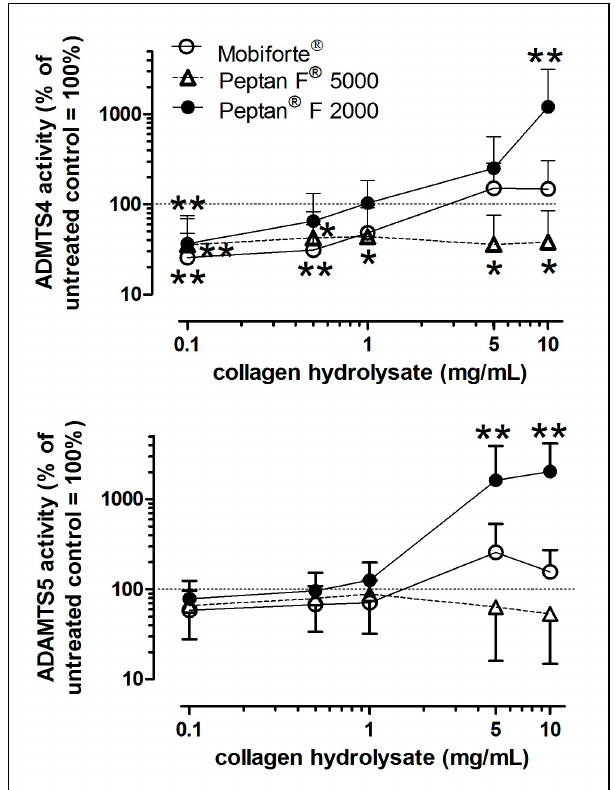
Figure 5. Concentration-dependent effects of CHs on the activities of aggrecanases. The activities of rhADAMTS4 ( A ) and rhADAMTS5 ( B ) in the presence or absence of 0.1, 0.5, 1, 2 and 10 mg/mL of Mobiforte ® , Peptan ® F 5000 or Peptan ® F 2000 were determined using the rhAggrecan-IGD as a substrate. The activities of both aggrecanases are expressed as the percentage of untreated controls (=100%). Data are shown as the mean + SD ( n = 4–6). Significant differences between treated and untreated controls (100%) were defined with p-values as follows: * 0.01< p < 0.05, ** 0.001 < p < 0.01.